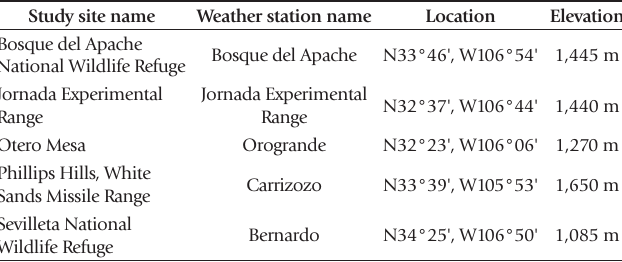
Table 2. U.S. National Weather Service weather stations that